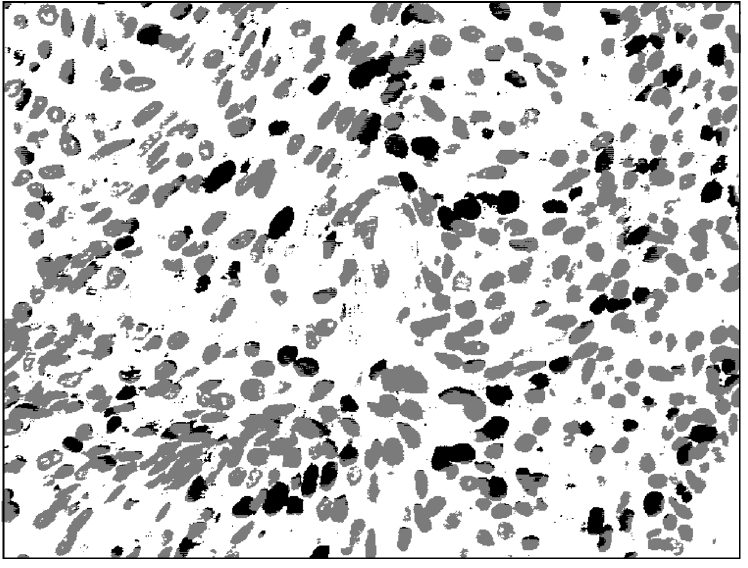
Fig. 8. Result of classification of specimen. Black is the class of positive staining reaction, and grey is the class of negative staining reaction.